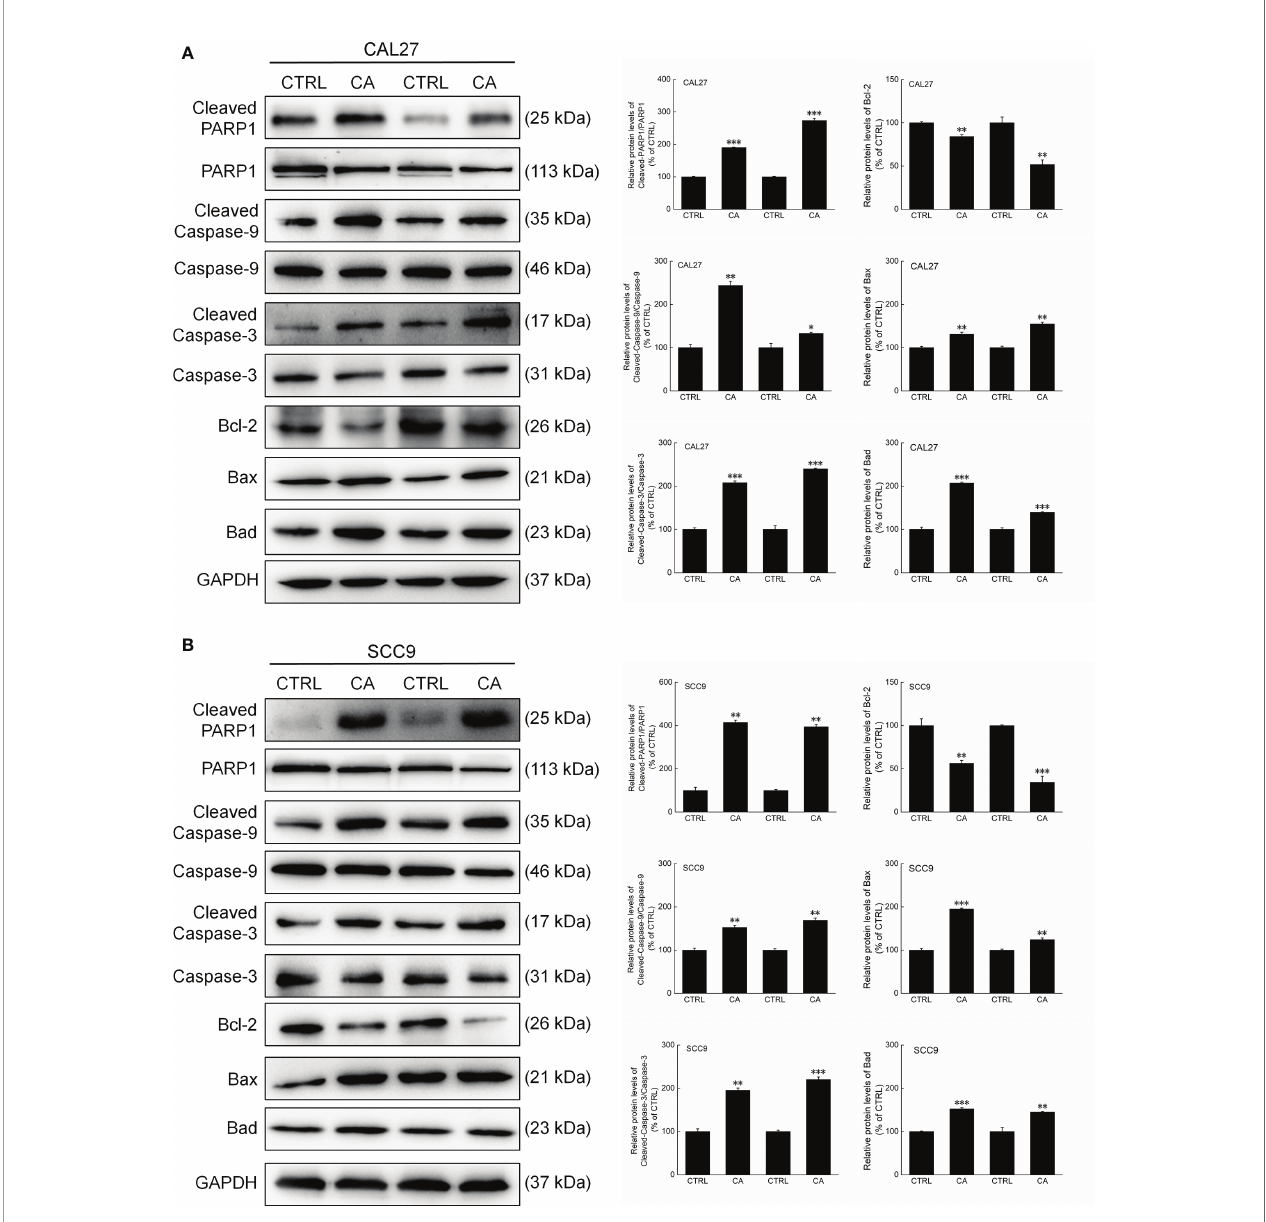
FIGURE 3 | CA treatment changed the levels of apoptosis-related proteins in OSCC cells. CA treatment signi fi cantly enhanced the ratios of Cleaved PARP1/PARP1, Cleaved Caspase-3/Caspase-3, and Cleaved Caspase-9/Caspase-9; downregulated Bcl-2 and upregulated Bax and Bad in (A) CAL27 and (B) SCC9 cells ( n = 3). The target-protein levels were normalized using the GAPDH levels, and the data are expressed as mean ± SEM. * P < 0.05, ** P < 0.01 and *** P < 0.001 versus CTRL